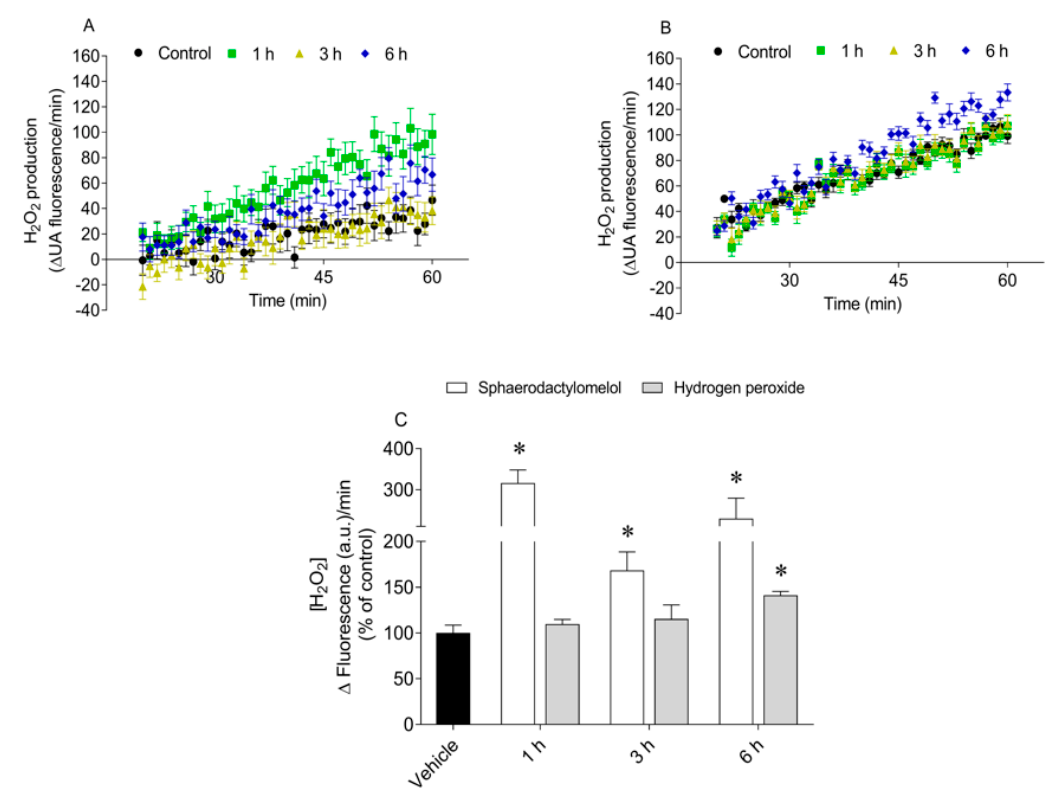
Figure 2. Production of H 2 O 2 by MCF-7 cells treated with ( A ) sphaerodactylomelol (48 µ M) and ( B ) H 2 O 2 (200 µ M) for 1, 3, and 6 h. MCF-7 H 2 O 2 levels following 1, 3, and 6 h treatment with sphaerodactylomelol and H 2 O 2 ( C ). Values represent mean ± SEM of at least three independent experiments carried out in triplicate. Symbols represent significant differences ( p < 0.05) when compared to: * control.